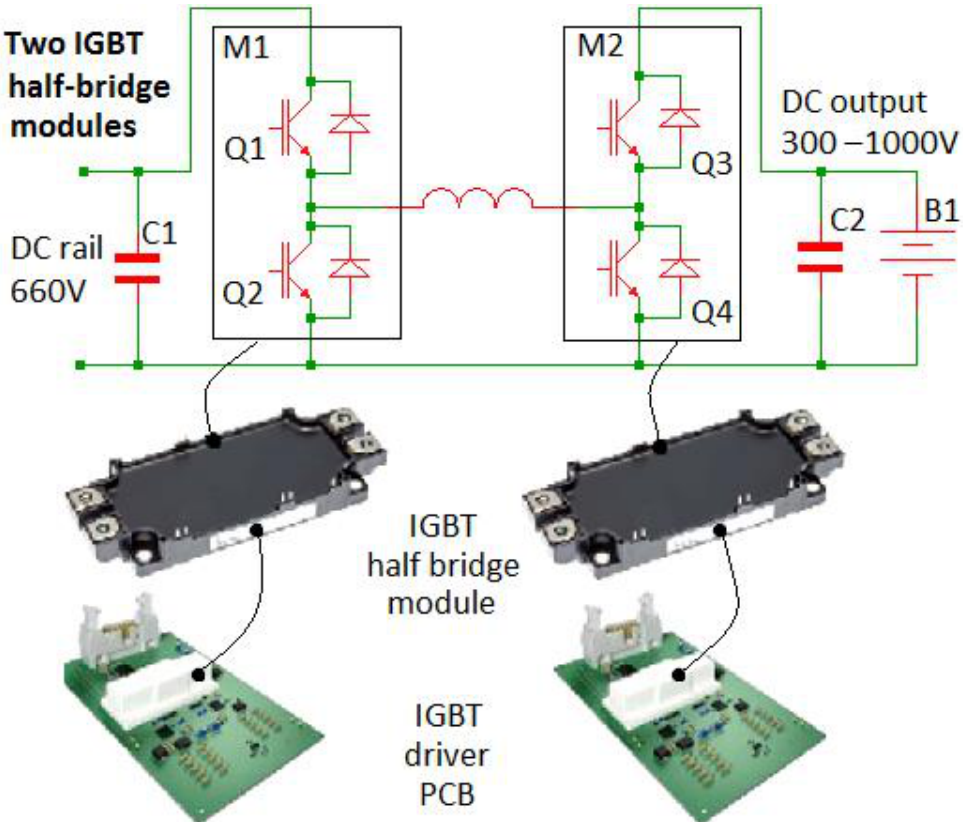
Figure 3. Buck-Boost converter, based on half-bridge IGBT modules with drivers (see Table A1 Appendix A).